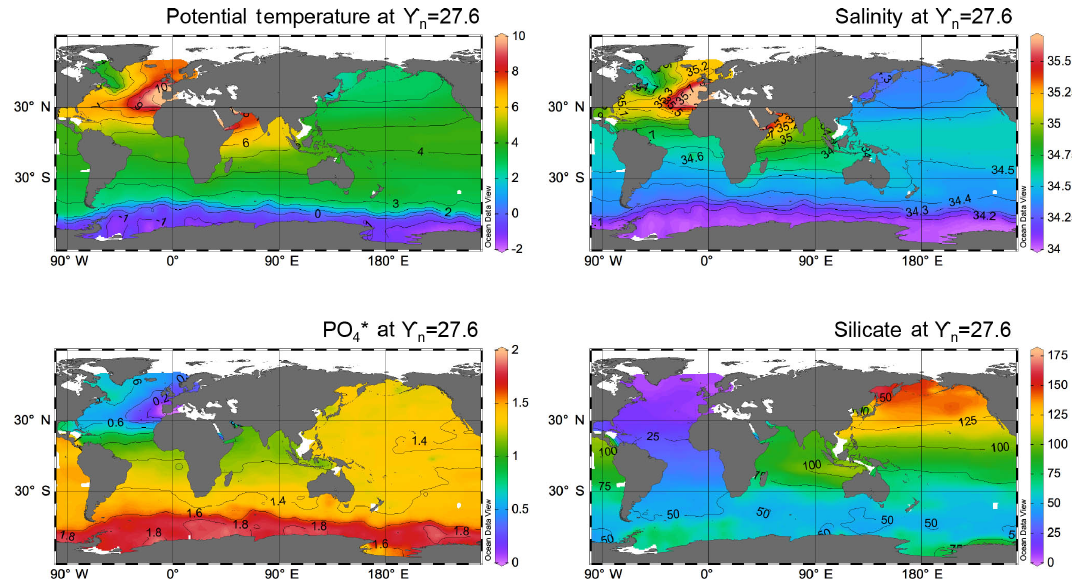
Figure A4. Potential temperature, salinity, PO ∗ , and silicate on the 27.6 isopycnal horizon. The depth of this horizon is shown in Fig. 8 and 4 averages ∼ 1000m in the basins and is in the mixed layer in the Southern Ocean. Data are from GLODAPv2 (Key et al., 2015; Olsen et al., 2016) with profiles, maps, and sections plotted in ODV (Schlitzer, 2015).